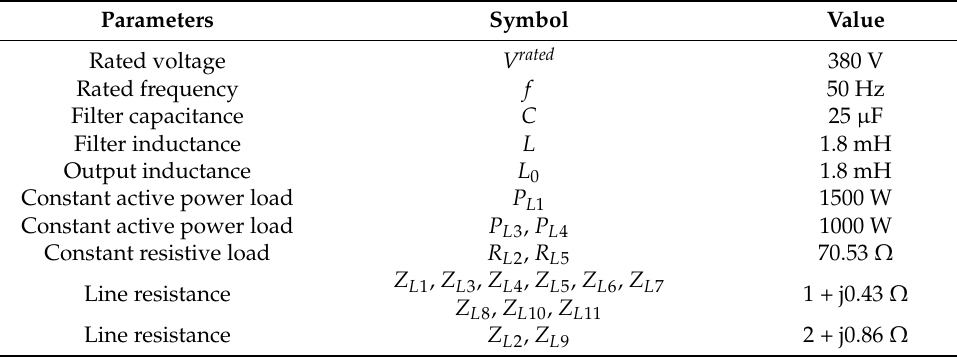
Table 1. Specifications of the test microgrid (MG).